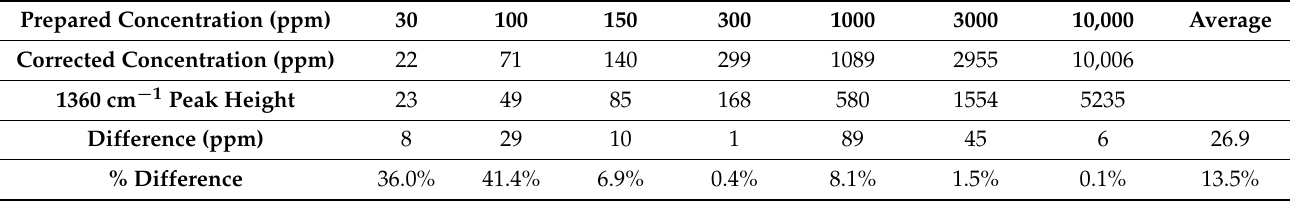
Figure 3. Plots of 1360 cm − 1 Raman HCO 3 − peak as a function of concentration in water containing 2650 ppm sulfate, ( a ) Series 1: 0 to 10,000 ppm, and ( b ) Series 2: 0 to 1000 ppm with expanded view of standard deviation for the 500 ppm sample. Table 1. Series 1 prepared HCO 3 − concentrations in water containing 2650 ppm sulfate, corrected concentrations based on the linear fit to the data, measured 1360 cm − 1 peak heights, ppm and percent differences between prepared and corrected calculations, and average values.